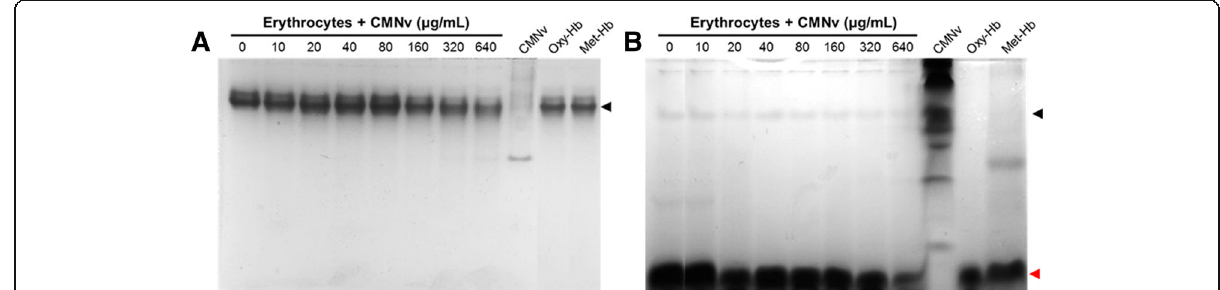
Fig. 2 PAGE of hemoglobin under ( a ) non-denaturing and ( b ) denaturing conditions – erythrocytes incubated with CMNv. Erythrocytes treated with different concentrations of CMNv for 24 h were centrifuged and soluble hemoglobin was used in this experiment. Lanes 1 – 8 show the erythrocytes treated with different venom concentrations, lane 9 shows 50 μ g of CMNv, lanes 10 and 11 show Oxy-Hb and Met-Hb controls, respectively. The hemoglobin (64 kDa) is marked with a black arrow, α -globin and β -globin (16 kDa) are marked with a red arrow